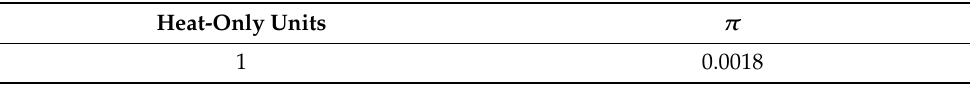
Table A6. Emission coefficients of the CHP